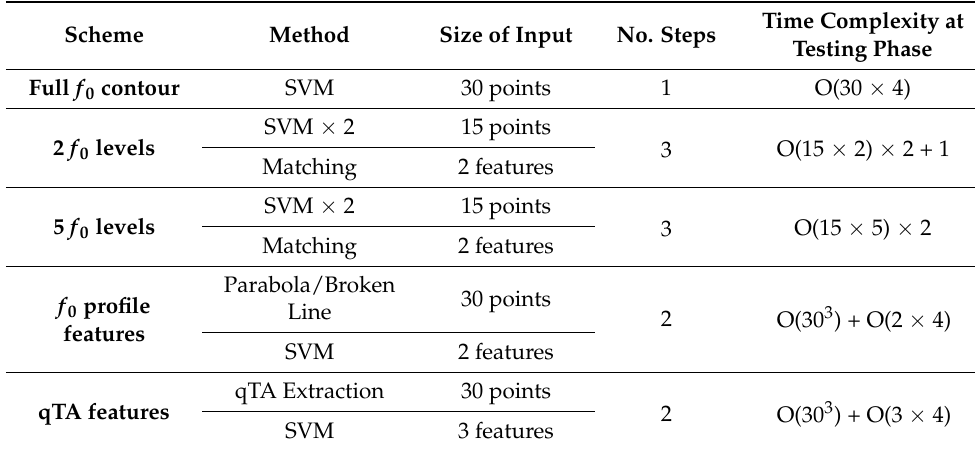
Table 8. Time complexity of different tone recognition